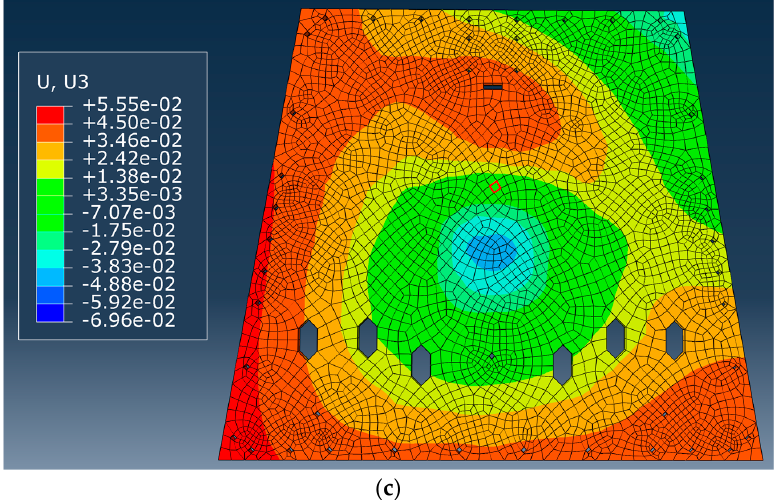
Figure 18. Calculation results of the modified finite element model (unit: mm) ( a ) X-direction ( b ) Y-direction ( c ) Z-direction.